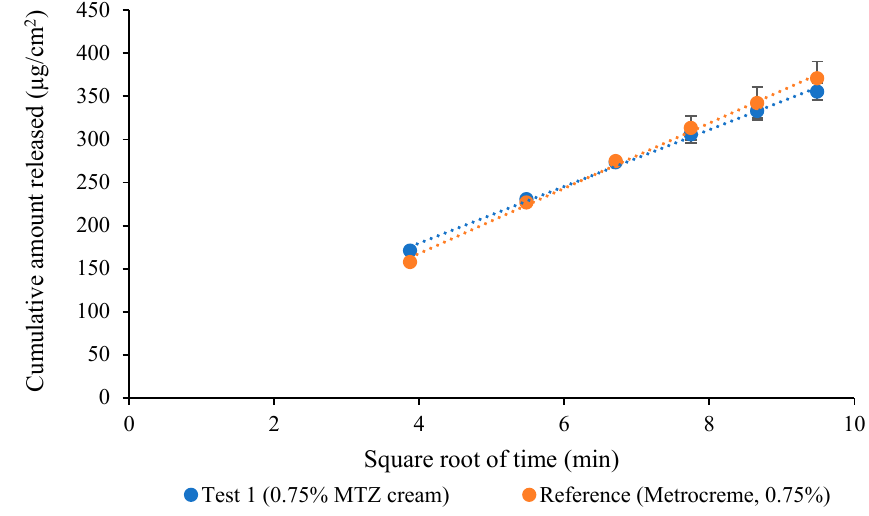
Figure 2. Release-rate curves from 0.75% MTZ cream (T 1 ) vs. Metrocreme ® , 0.75% MTZ (R).